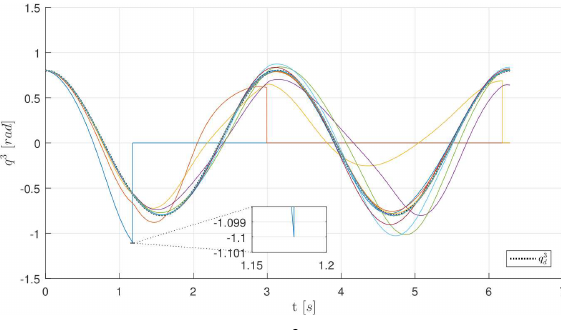
Figure 11.Trajectory tracking q 3 through iterations - CO Applying the BEA algorithm with (16) parameters, the desired accuracy was obtained after 21 iterations, with maximum tracking